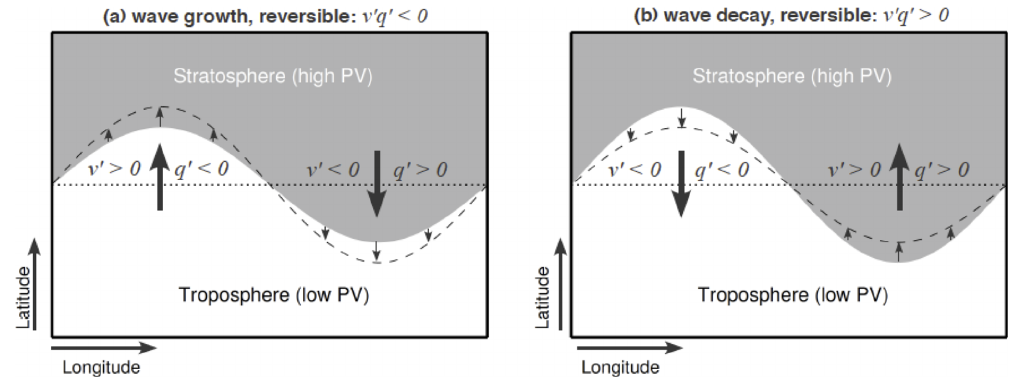
Figure 1. A schematic of a reversible wave growth (a) and decay (b) at the tropopause in a horizontal plane. Grey shading represents high-PV air (from the stratosphere; PV also generally increases towards the pole), and no shading (white) represents low-PV air (from the troposphere; PV also generally decreases towards the Equator). Arrows denote the movements of the air as the wave grows or decays; v (cid:48) represents meridional movements; q (cid:48) represents changes in the PV following the meridional movements. Recall that [ v (cid:48) q (cid:48) ] is EP flux divergence (only for the QG dynamics). For a detailed description of the schematic, see the